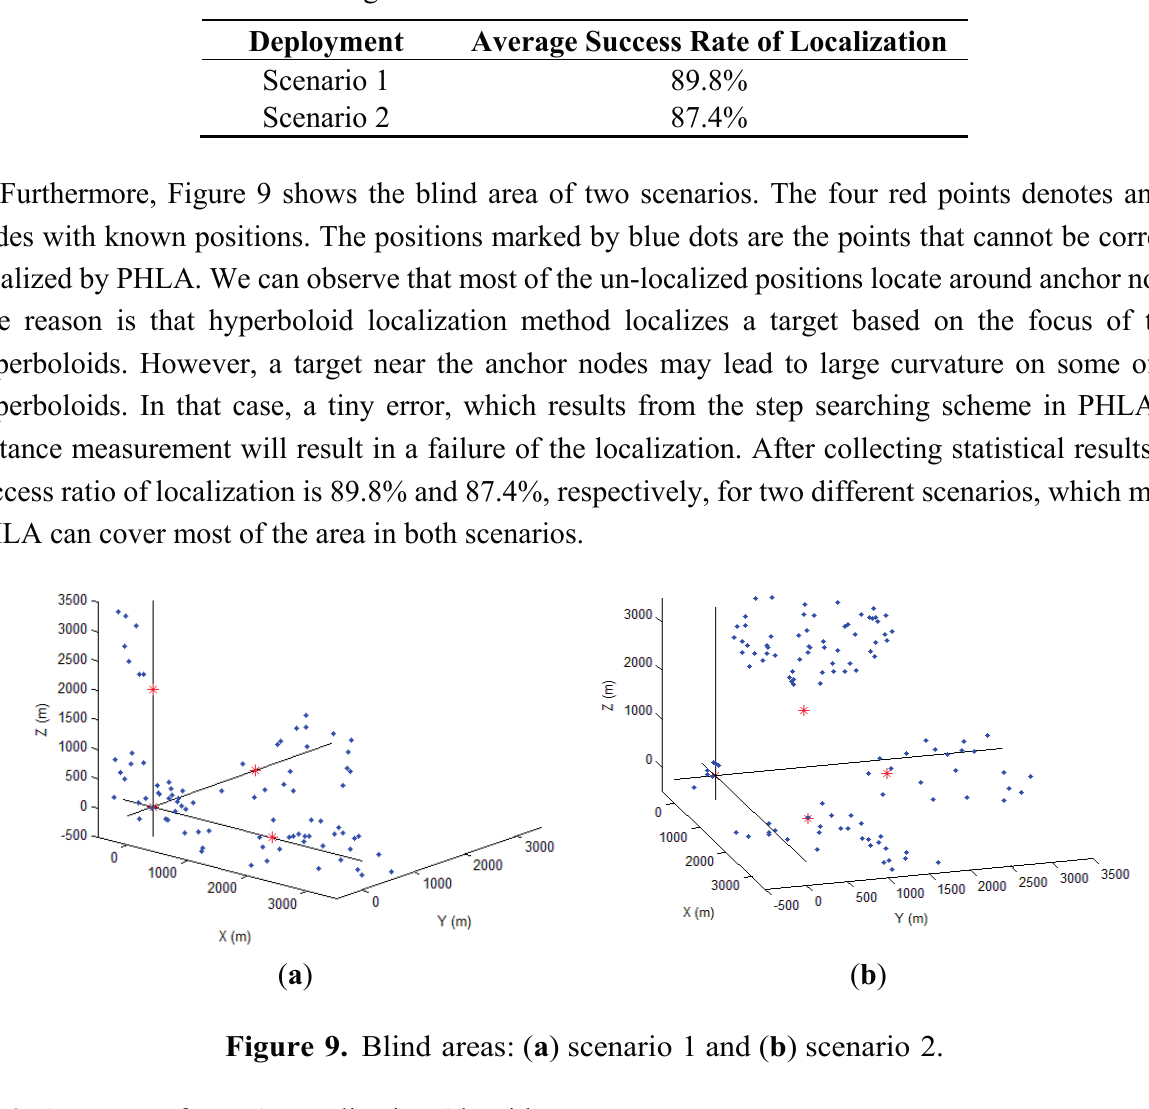
Table 4. Average success rate of localization in different scenarios.